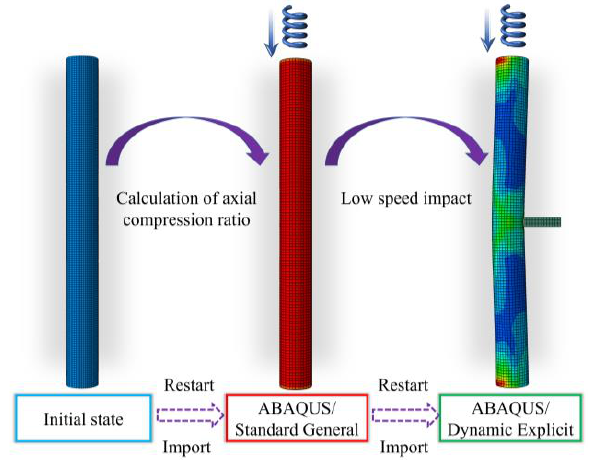
Figure 3. The whole analysis process.